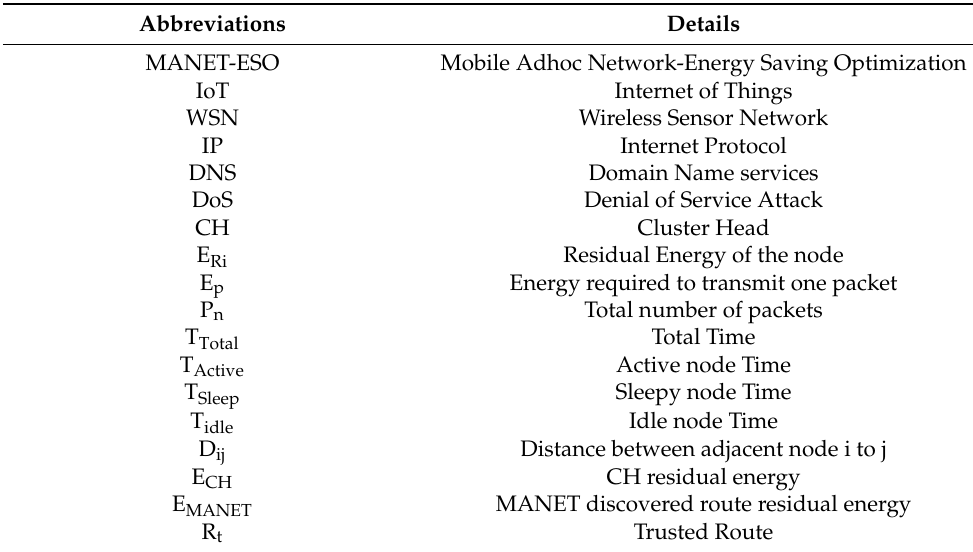
Table 1. Abbreviations and Details.